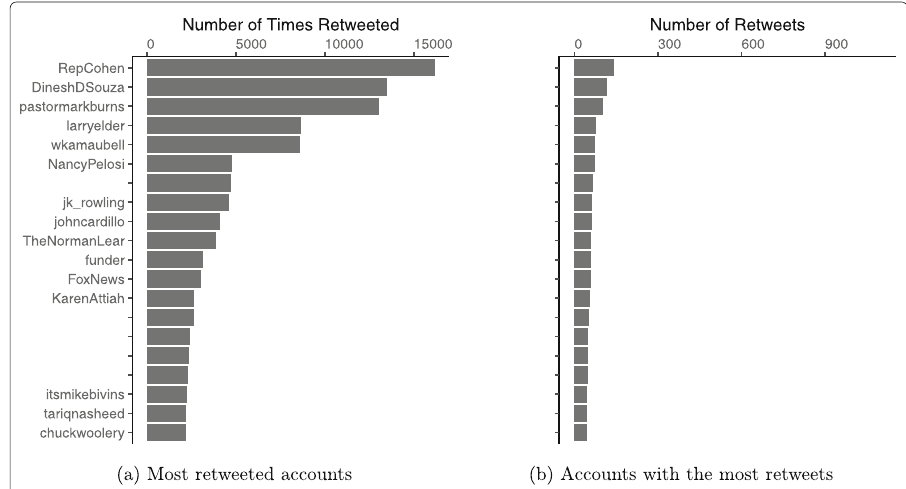
Fig. 2 The 20 nodes that ( a ) were retweeted the most (i.e., with the largest in-degrees) and ( b ) posted the most retweets (i.e., with the largest out-degrees). We also show the corresponding in-degrees and out-degrees, respectively. The largest in-degrees are much larger than the largest out-degrees, although the vast majority (94%) of the nodes were never retweeted at all. We show the account names (i.e., handles) for verified accounts; blank labels correspond to accounts that are not verified. Most accounts in panel ( a ) are verified accounts, whereas none of the nodes that posted the most retweets (i.e., the accounts in panel ( b )) are verified accounts